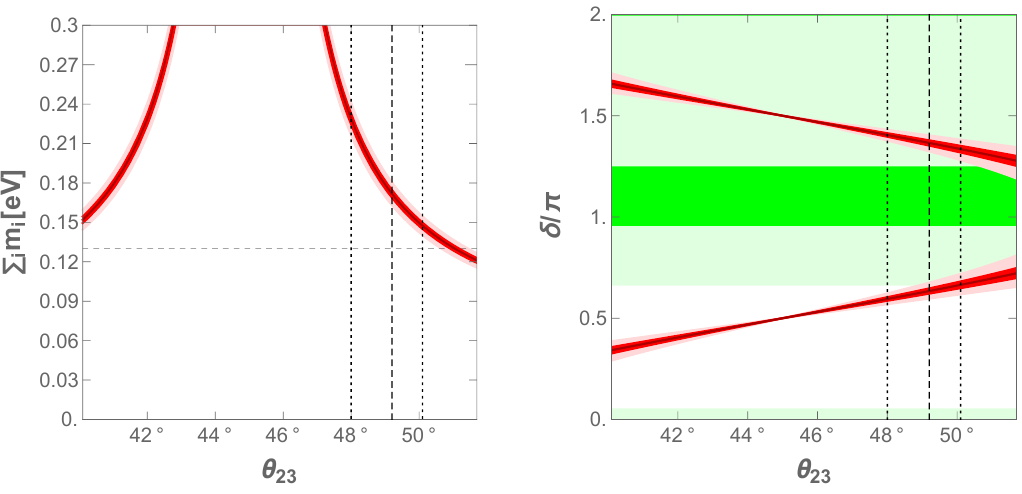
Figure 7 . Left plot: predictions of the sum of the three active neutrino masses as a function of θ 23 . Right plot: predictions of the Dirac CP phase as a function of θ 23 . The predictions are plotted as red curves, dark (light) red bands corresponding to the parameters fixed to their central value and 1 (3) sigma value given in [68]. In both plots, the boundary of x axis corresponds to the 3 σ range of θ 23 , while the vertical dashed line shows the central value of θ 23 and the 1 σ range of θ 23 are enclosed by the vertical dotted lines. The horizon dashed line in the left plot represents the upper bound on the sum of the active neutrino masses given in [69], which is P m ν < 0 . 13 eV at 95 % confidence level. The (light) green band in the right plot shows the (3) 1 σ range of the Dirac CP -violating phase obtained in